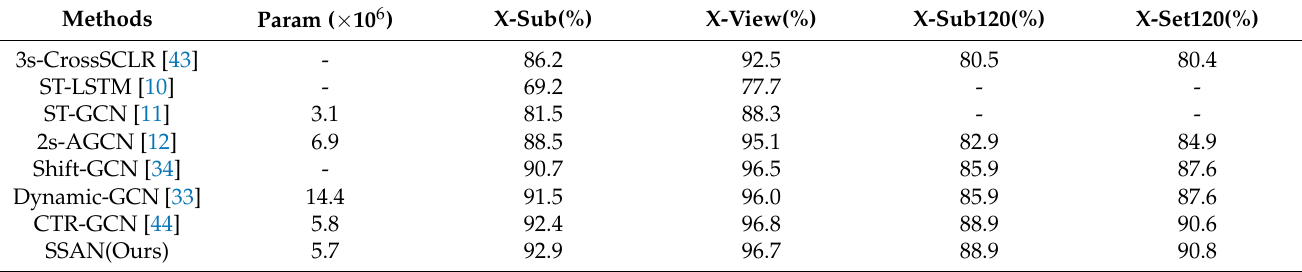
Table 2. On NTU RGB+D and NTU RGB+D120 skeleton datasets, the recognition accuracy and parameter size are compared with the most advanced